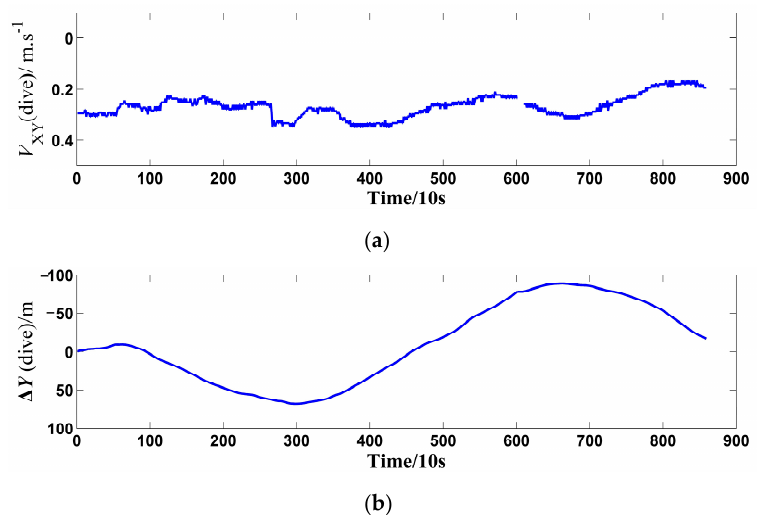
Figure 16. Identification results of Petrel-L in dive motion: ( a ) horizontal velocity and ( b ) trajectory error.